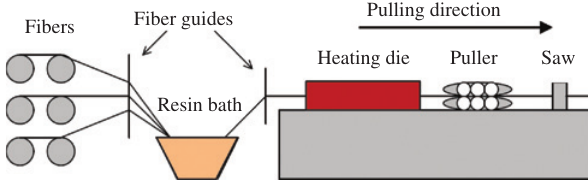
Figure 1 Schematic view of a pultrusion